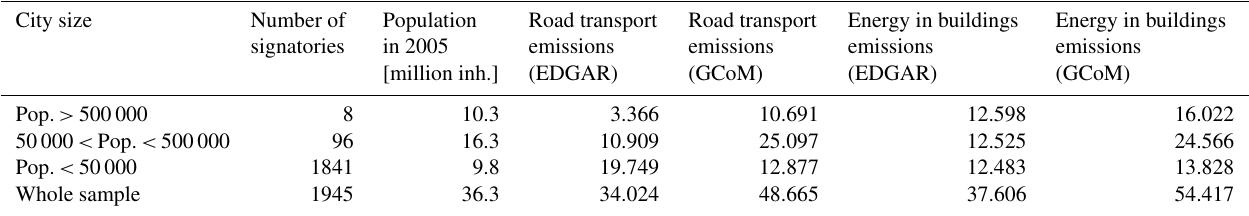
Table A1. Absolute emissions (MtCO 2eq ) for road transport and energy in buildings sectors in EDGAR v5.0 and GCoM datasets of selected signatories.